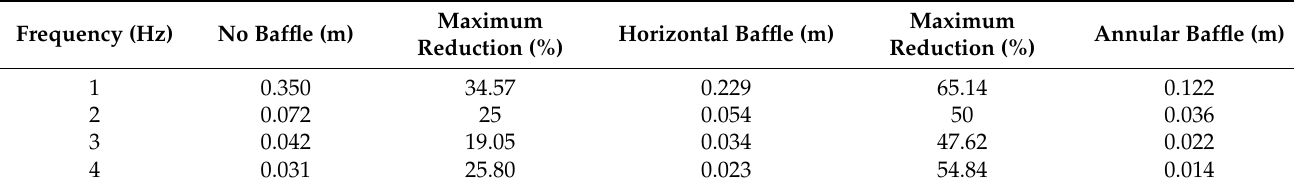
Figure 14. Effect of the baffle on the fluid surface height variations at different frequencies. ( a ) Changes in fluid surface height at the frequency of 1 Hz; ( b ) changes in fluid surface height at the frequency of 2 Hz; ( c ) changes in fluid surface height at the frequency of 3 Hz; ( d ) changes in fluid surface height at the frequency of 4 Hz.